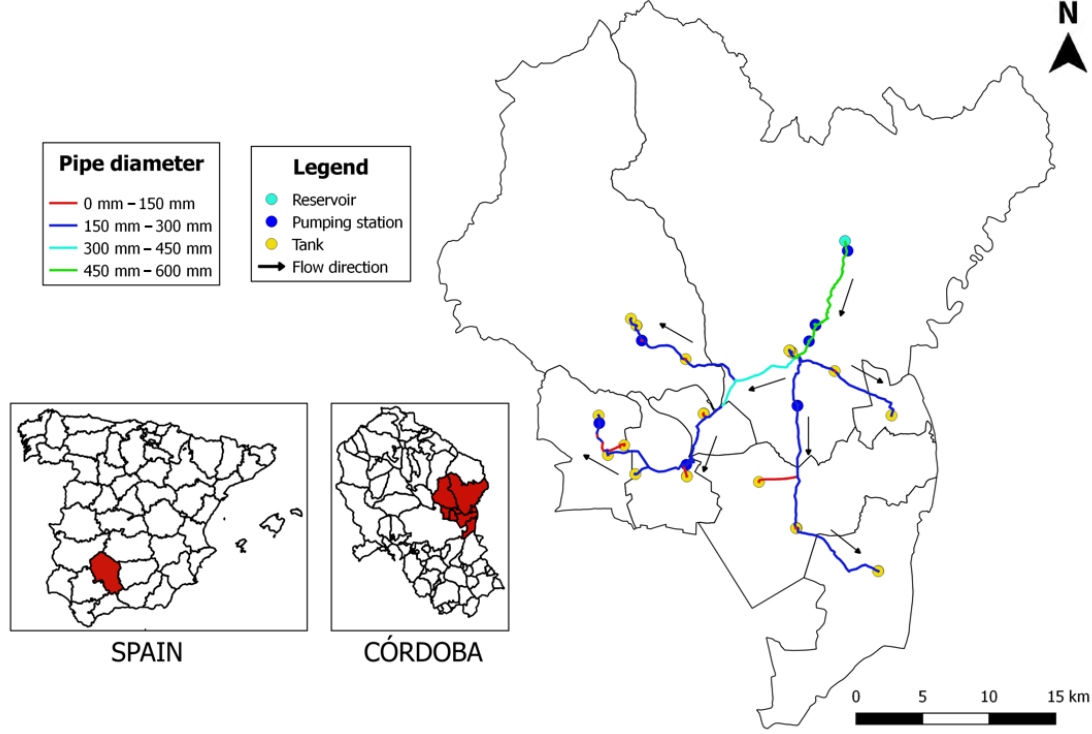
Figure 2. Location and layout of ES.